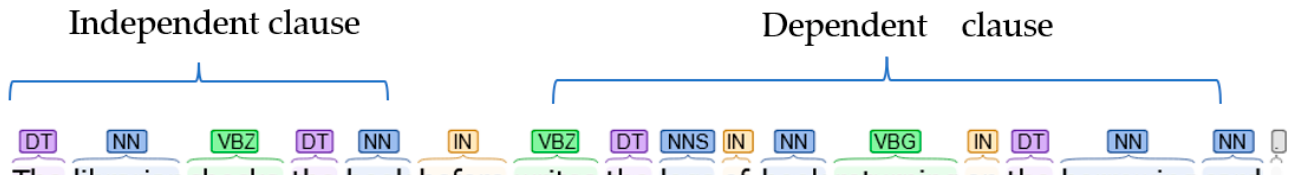
Figure 5. The example of a complex sentence.